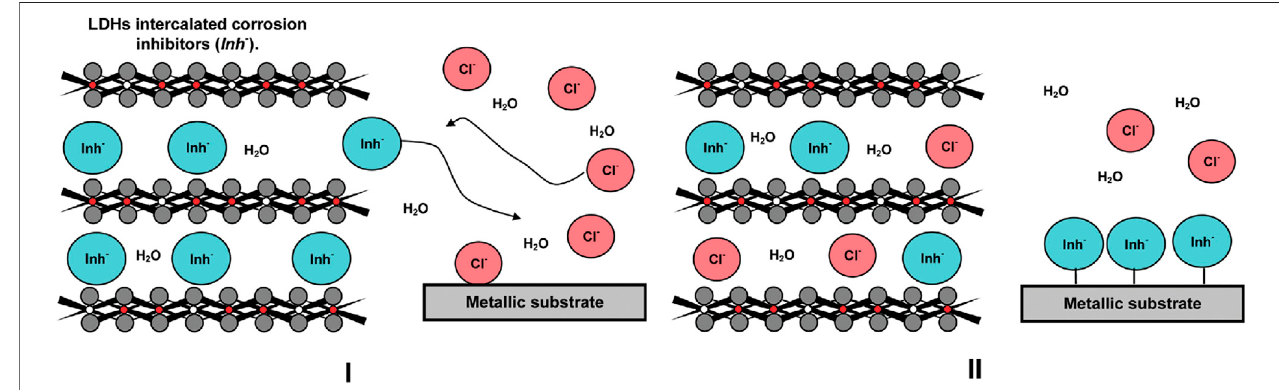
FIGURE12| MechanismdiagramofLDHsincorrosionprotection(Tedimetal.,2010).(I)Anion(Cl − )inthesolutiontriggersthereleaseoftheinhibitors(Inh − ),and(II) LDHs play a double-role, providing inhibitors to protect the metallic substrates and entrapping aggressive species from the environment.